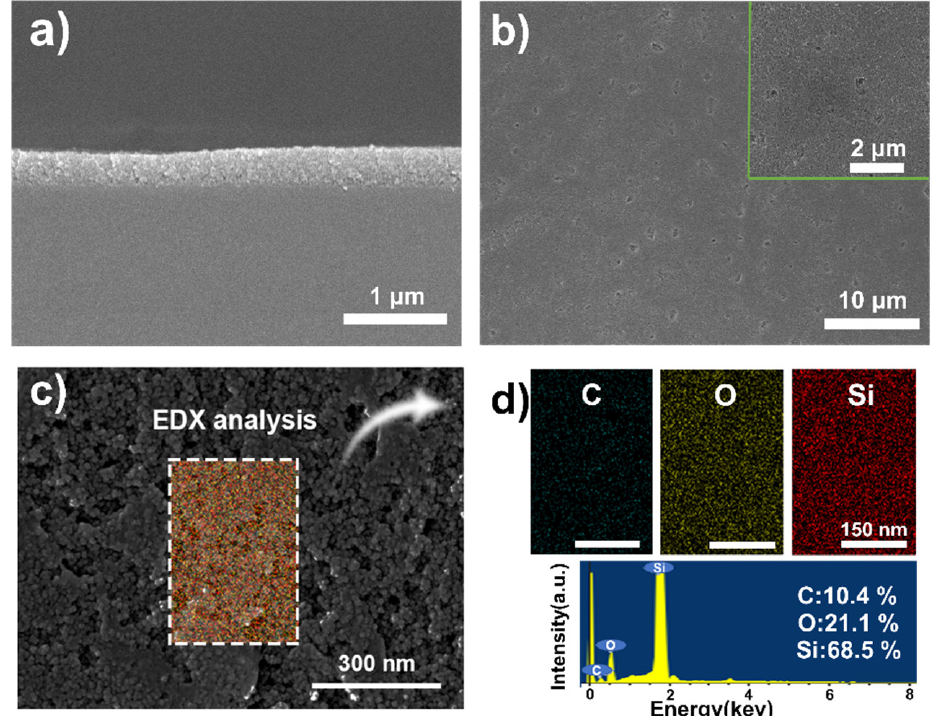
Figure 6. ( a ) Cross-sectional SEM image, ( b ) surface SEM image, ( c ) SEM image of high magnification, and ( d ) elemental (C, O, and Si) mappings and EDX spectrum of the nanofilm with spray passes of